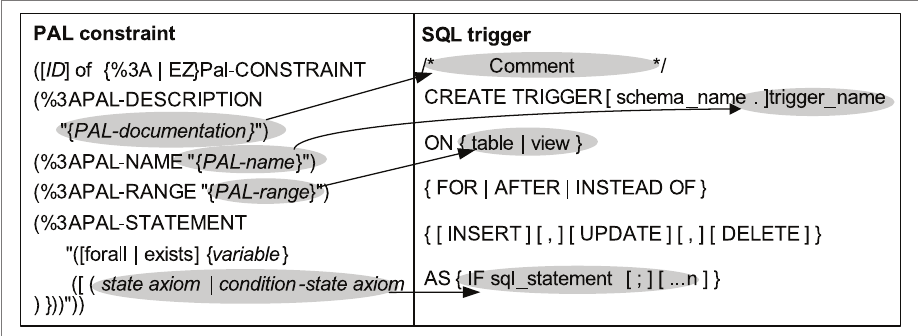
Fig. 1 . The mapping of a PAL constraint to an SQL trigger (Vasilecas and Bugaite 2006)